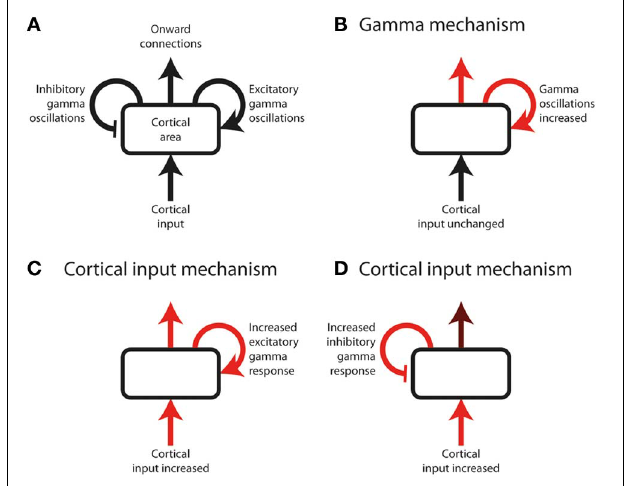
FIGURE 1 | Schematic of a hypothetical experiment, measuring cortical gamma oscillations, that risks being non-discriminatory. (A) Annotated schematic of diagram format used in this figure. A cortical area (rounded rectangle) receives an input and sends out onward connections. Onward connections are influenced both by the cortical input, and by the effect of local gamma oscillations (curved arrows), which can either be excitatory or inhibitory with respect to onward connection strength. Onward connection strength can include perceptual or cognitive judgments, and therefore be inferred from behavioral responses as well as by measurement of downstream neural responses. Note that cortical input can represent bottom-up input from subcortical or lower cortical areas, or top-down input from higher cortical areas. (B–D) Three potential underlying sequences of neuronal responses in a hypothetical experiment. Red arrows indicate neural processes increasing in magnitude as a function of the experimental effect under study (e.g., response to a stimulus, or effect of selective attention). Gamma oscillations increase equally in all three examples, and therefore the magnitude or direction of gamma power change in isolation cannot be used to distinguish between the underlying neural systems; inferring the role of gamma requires knowledge of how the cortical input and output change, in addition to how gamma changes, as a function of the effect under study. (B) The cortical input is unchanged, but the effect under study is primarily mediated by an increase in gamma oscillations, which lead to increased onward connections. (C,D) The effect under study is primarily mediated by increased cortical input. Gamma oscillations increase as a mechanistic consequence of this increased input, irrespective of whether their role is excitatory or inhibitory. Determining the role of gamma therefore requires knowledge of the onward connection strength, which is more strongly increased (relative to the cortical input) if gamma is excitatory (C) than if it is inhibitory (D)